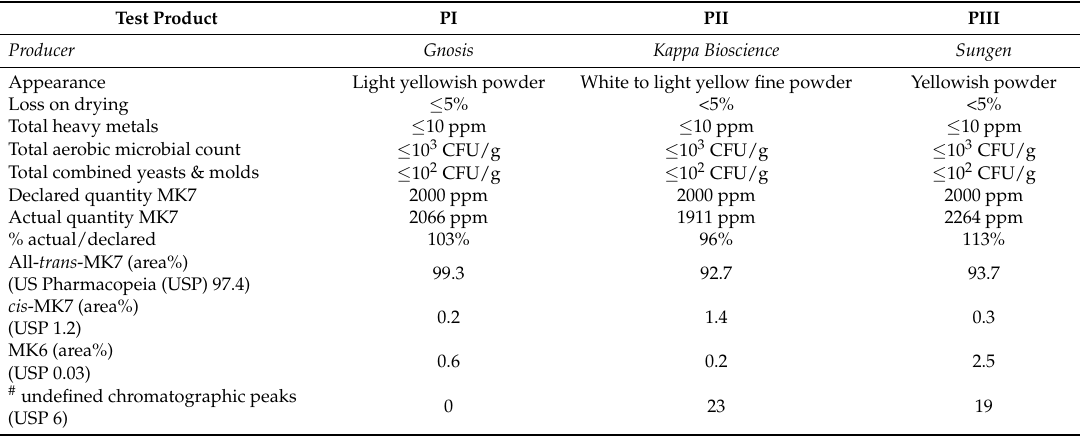
Table 1. Ingredients assay and specifications and purity